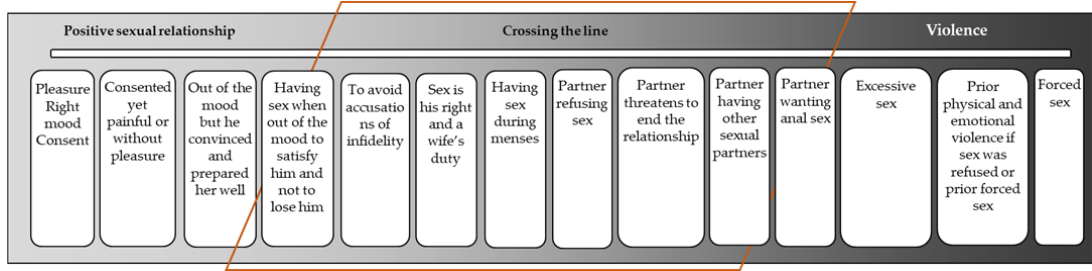
Figure 1. Women’s conceptualizations of sex and sexual violence.